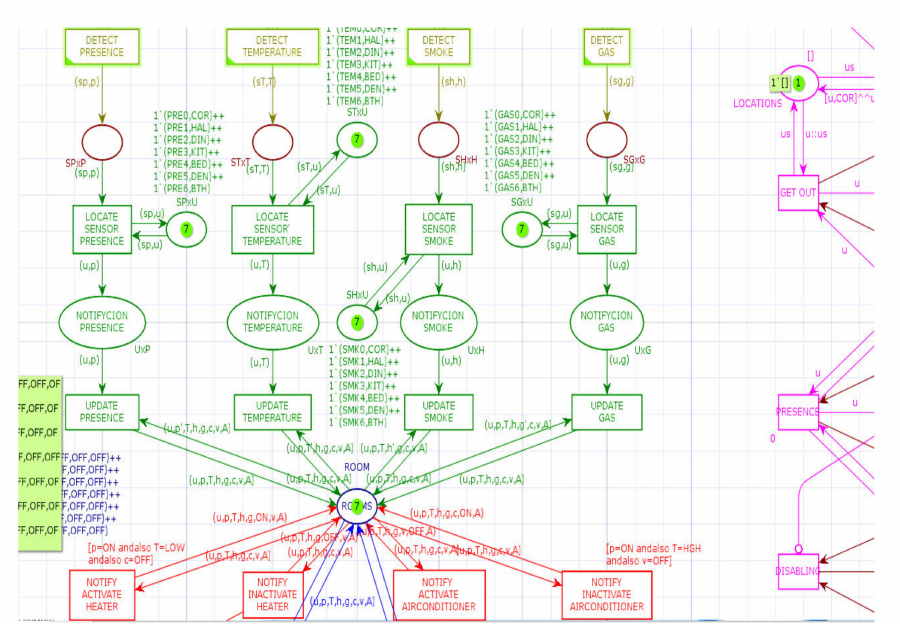
Figure 5. CPN systematically constructed using the SCM-IoT patterns.